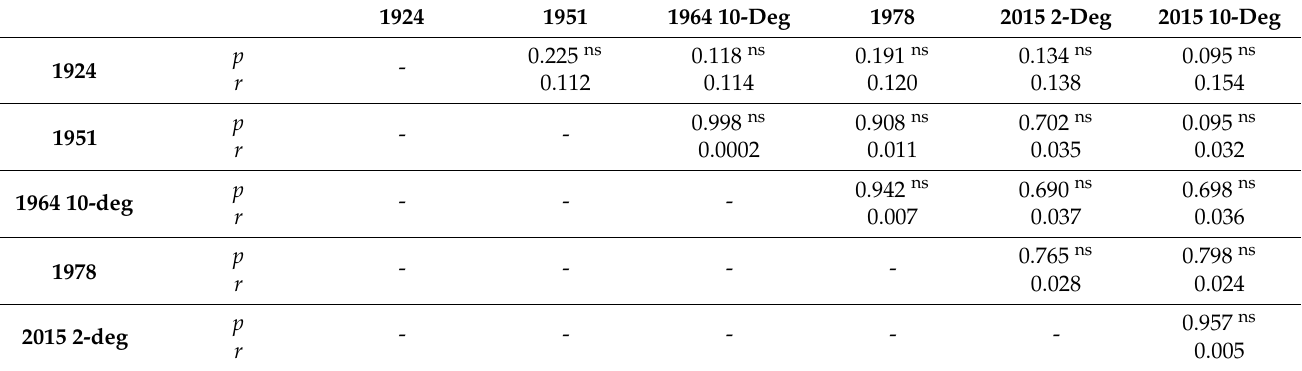
Table 3. Rank sum test and effect size for CIE 1931 x ( p -value and effect size ( r )).